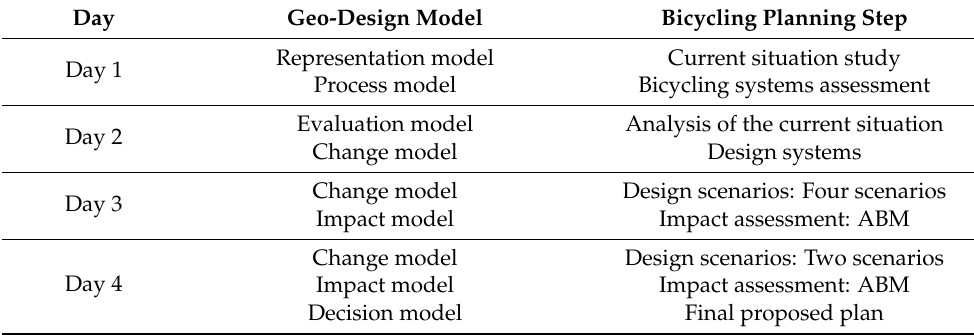
Table 2. Bicycling planning steps and geo-design models in the four days of workshops.